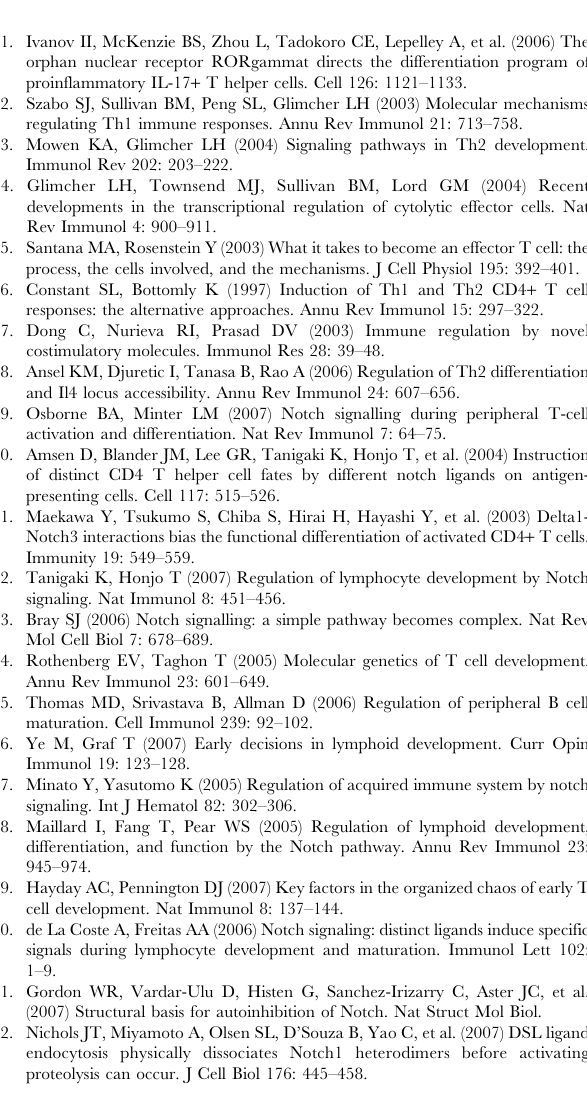
Table S4 Cell expansion regimens used in the experiments (A) CD4 + T cell passage regimen used for experiments described in Figure 1 & 2. (B) CD4 + T cell passage regimen 2 where T cells were expanded at a fixed time schedule regardless of their density in culture. Individual data point was denoted as circle in Figure 3– 6. (C) CD4 + T cell passage regimen 3 where T cells were expanded accordingly to their density in culture. Individual data point was denoted as diamond in Figure 3–6. ‘‘Seed’’ stands for